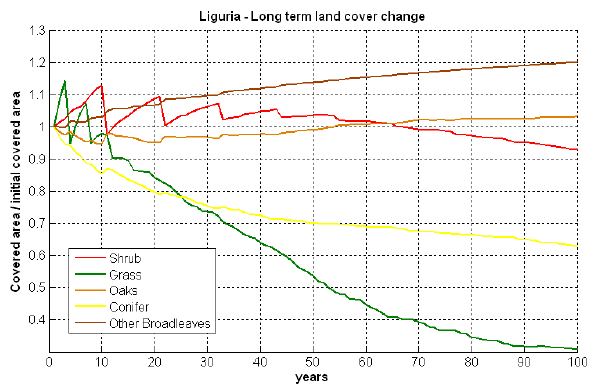
Fig. 3. Long term simulation obtained using the vegetation succes- sion model for Liguria case study. Figure 3. Long term simulation obtained using the vegetation succession model for Liguria case study.